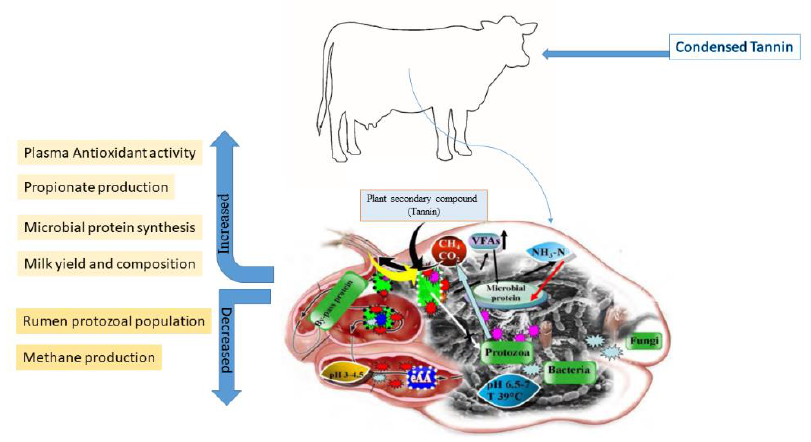
Figure 6. Main positive effect of plant secondary compounds assumed by diet.